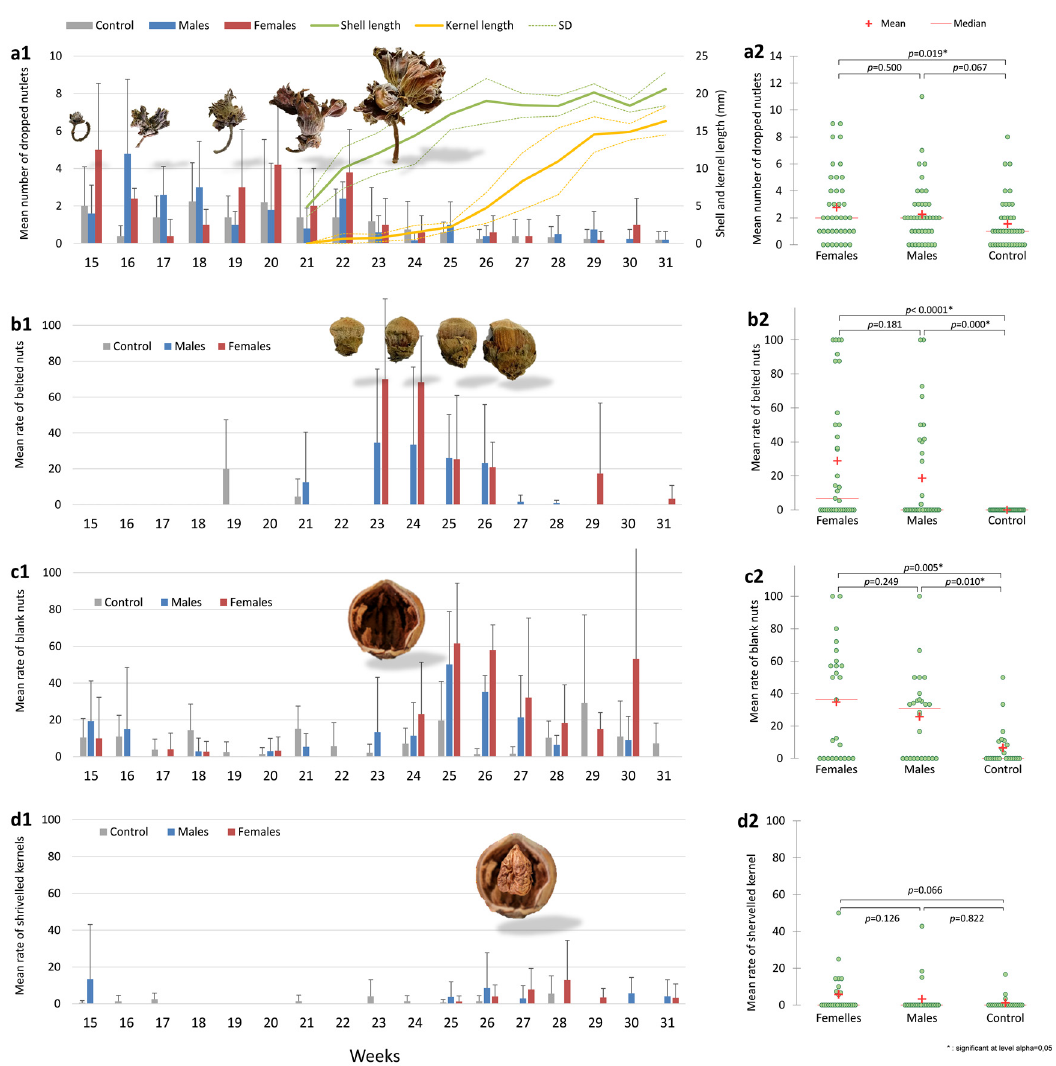
Figure 1. Non-exclusive damages observed per net sleeve based on stage of nut development and the presence of male or female hazelnut weevils: ( a1 ) mean number of nutlets dropped per sleeve according to nut development; ( a2 ) mean number of dropped nuts during the fructification stage (weeks 15 to 22), according to the presence of males or females; ( b1 ) mean number of belted nuts based on nut development; ( b2 ) mean number of belted nuts during shell expansion (weeks 23 to 26), according to the presence of males or females; ( c1 ) mean number of blank nuts according to nut development; ( c2 ) mean number of blank nuts during shell expansion and maturation (weeks 23 to 29); ( d1 ) mean number of shrivelled kernels according to nut development; ( d2 ) means of the shrivelled kernels during kernel expansion (weeks 26 to